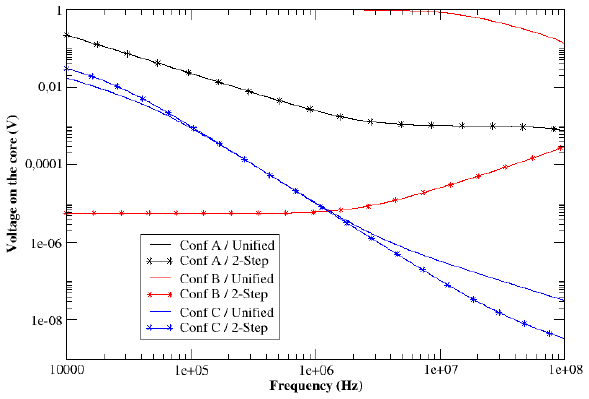
FIGURE 15. Voltage induced on the core V int (0) – Unified and two-step model results of various test setup